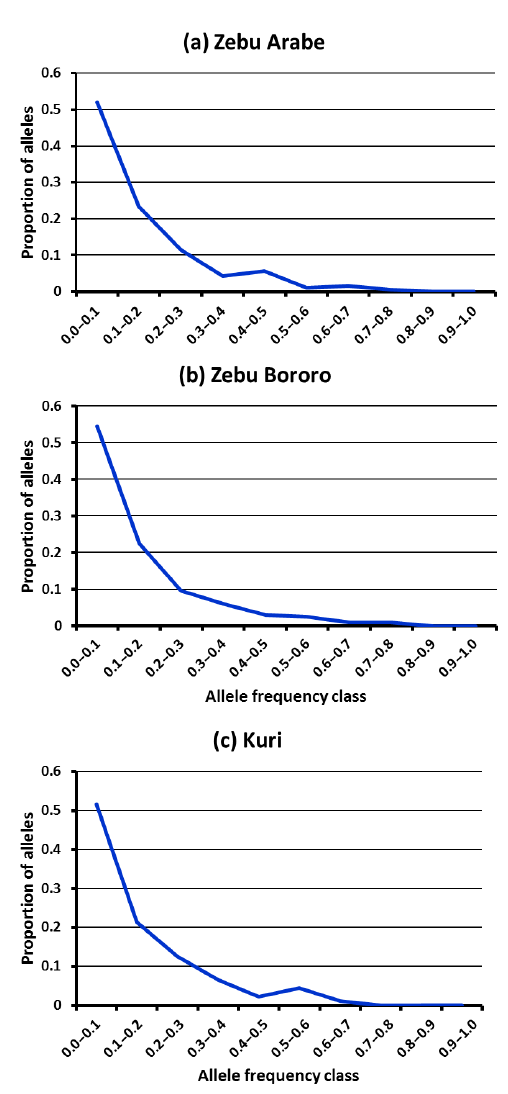
Figure 4. Mode shift analysis showing L-shaped distribution of al- lele frequencies in (a) Zebu Arabe, (b) Zebu Bororo and (c) Kuri breeds of Niger